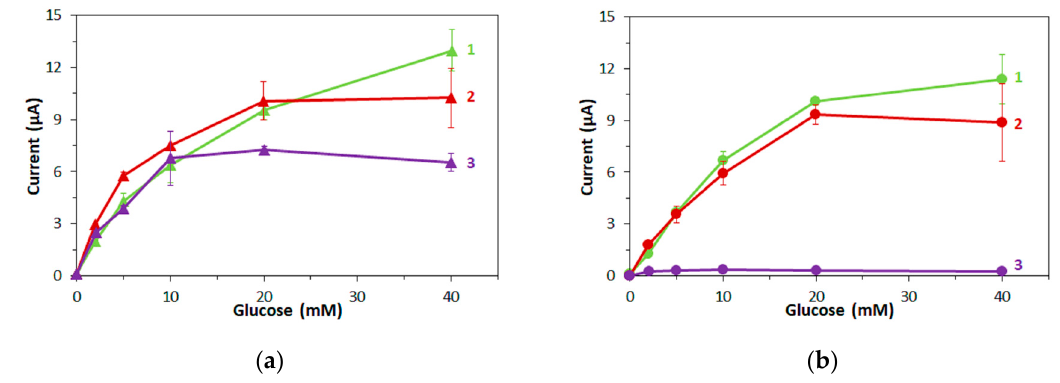
Figure 3. Dependency of current at 5 s after application of the potential on the glucose concentration. Enzyme: ( a ) FADGDH (QY), ( b ) Af GDH. Mediator: (1) 100 mM mPMS, (2) 100 mM ferricyanide,